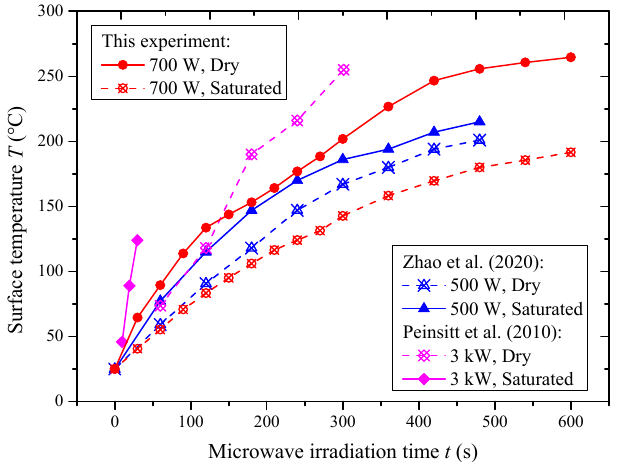
Figure 10. Microwave heating curves of sandstone under dry and water-saturated conditions [34,36].